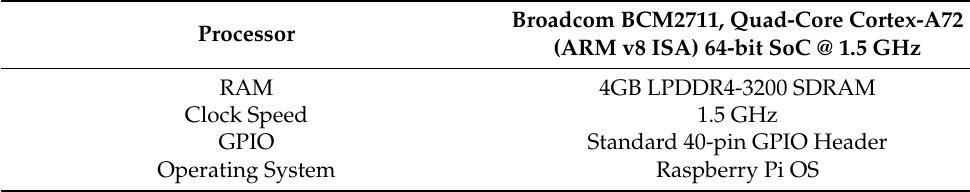
Figure 9. Experimental setup of the intelligent stick for the visually impaired. Table 2. Raspberry pi specifications.